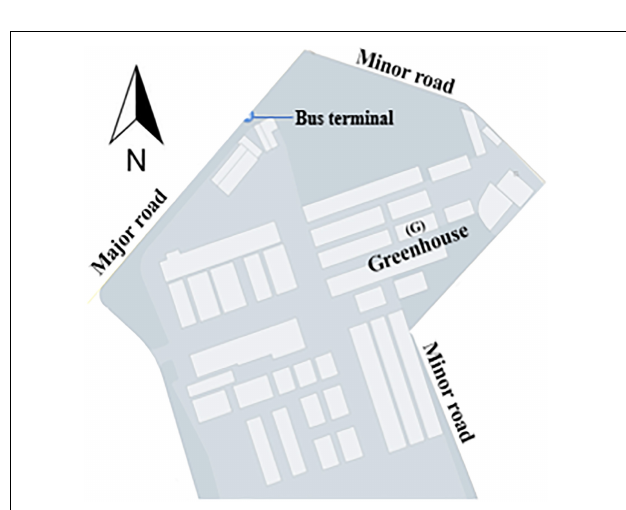
FIGURE 2 | Location of the experimental greenhouse (G) used for data collection for optimal sensor placement